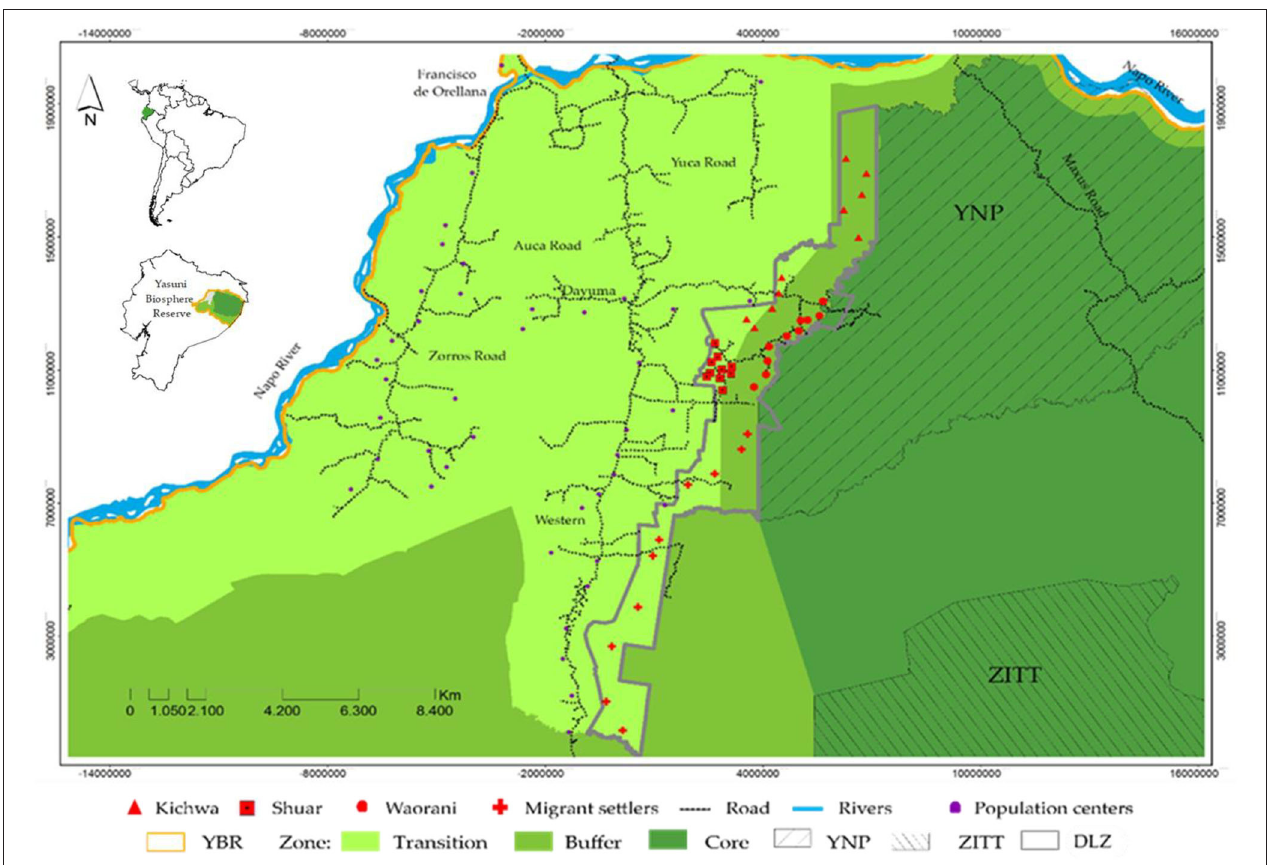
FIGURE 1 | Study area with social groups—Waorani, Shuar, Kichwa, and migrant settlers—in the Yasuní Biosphere Reserve, Ecuador (YBR, Yasuní Biosphere Reserve; YNP, Yasuni National Park; ZITT, Tagaeri-Taromenane Intangible Zone; DLZ, Diversity and Life